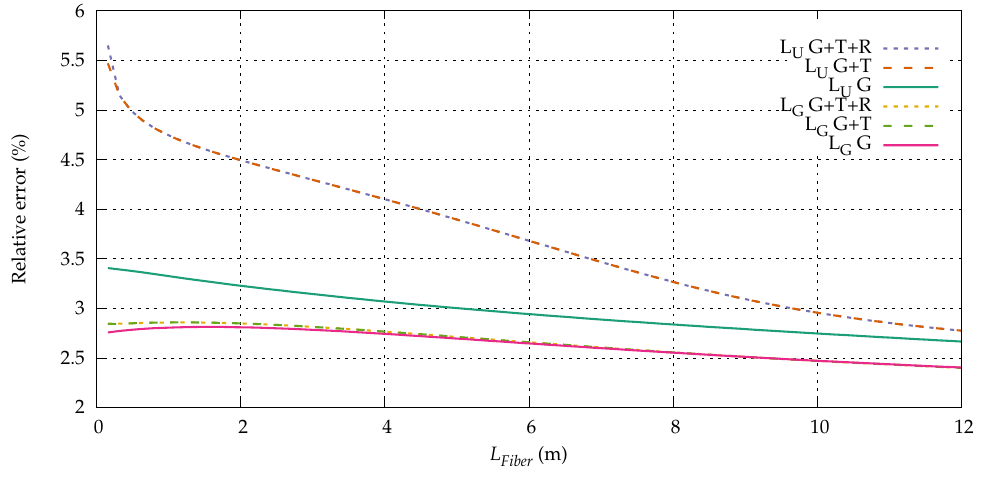
Figure 13. Simulated relative error considering the